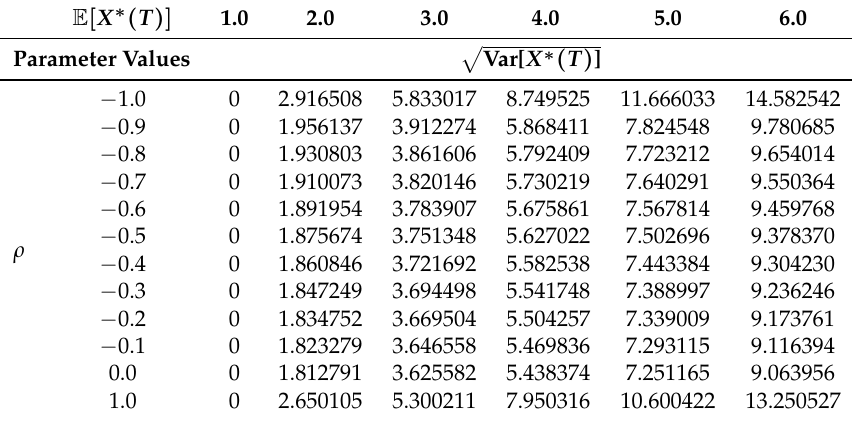
Table 2. The efficient frontier in the complete market with different ρ